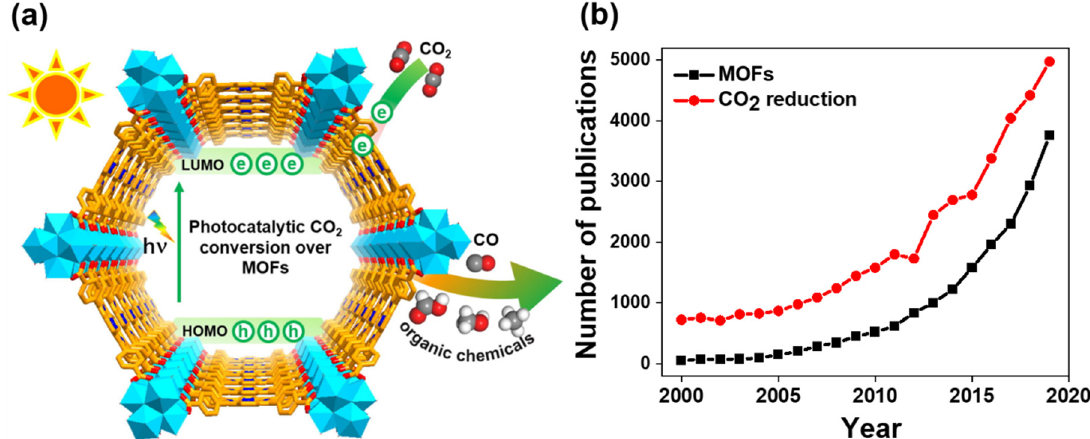
Figure 1. ( a ) Schematic illustration depicting photocatalytic CO 2 reduction into CO and value-added chemicals over metal–organic frameworks (MOFs). ( b ) Number of publications in the last 20 years along with the averages calculated from Scopus, Web of Science, and SciFinder for the entries “MOFs” and “CO 2 reduction” as of September 2020. Figure 1a reproduced with permission from [81].